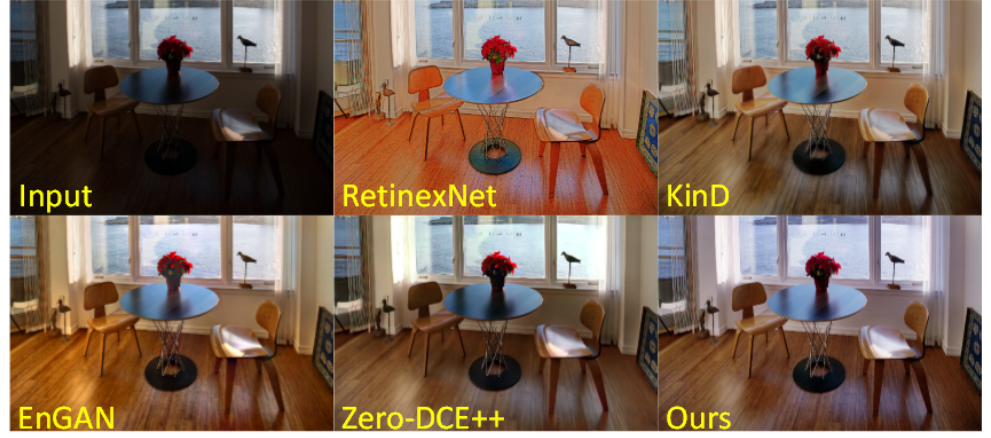
Figure 1. Comparison between state-of-the-art methods and ours. RetinexNet (2018) [1], KinD (2019) [2], EnGAN (2020) [3], Zero-DCE++ (2021)